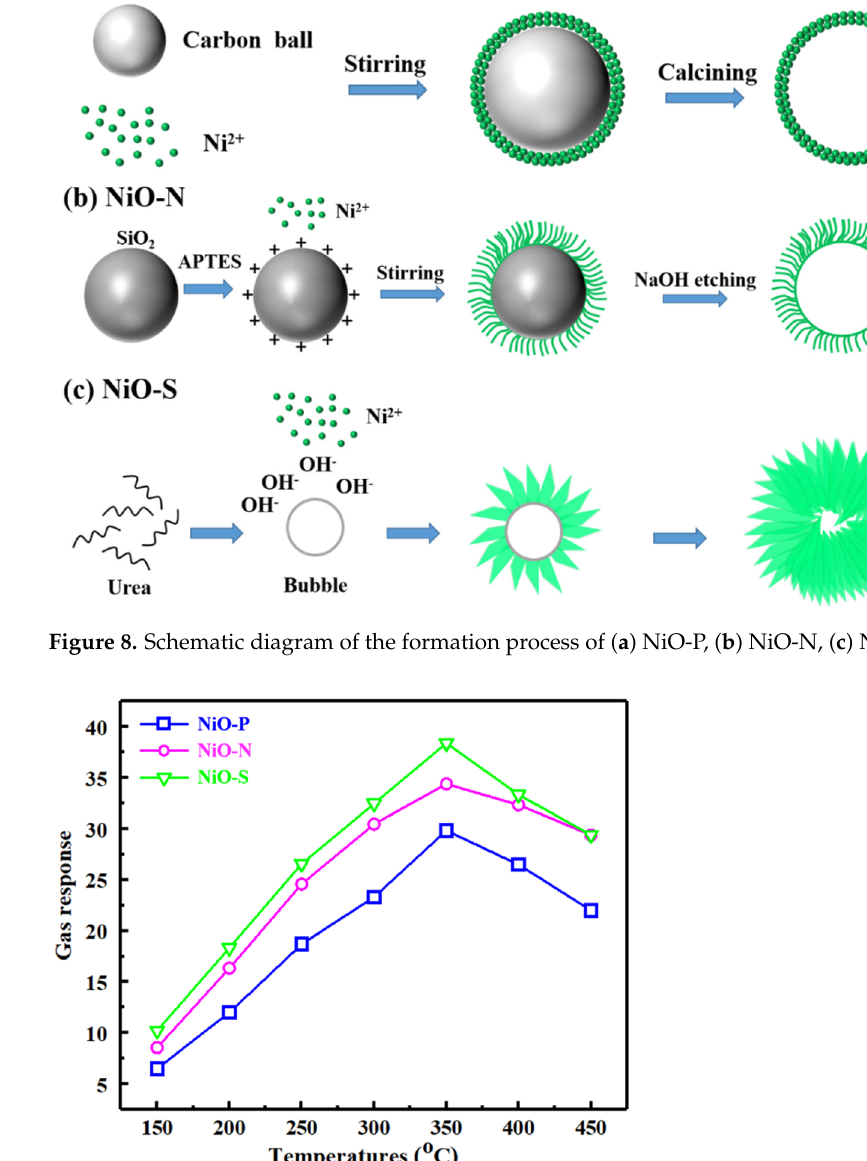
Figure 8. Schematic diagram of the formation process of ( a ) NiO-P, ( b ) NiO-N, ( c ) NiO-S.